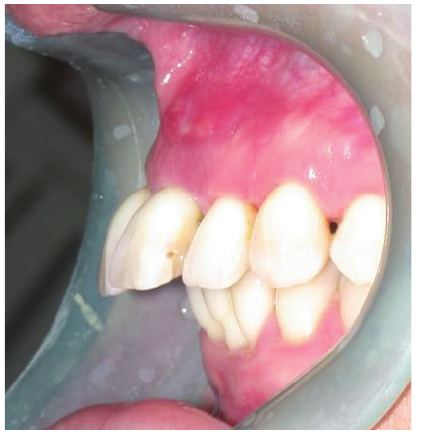
Figure 3: Left side view of patient upon presentation.